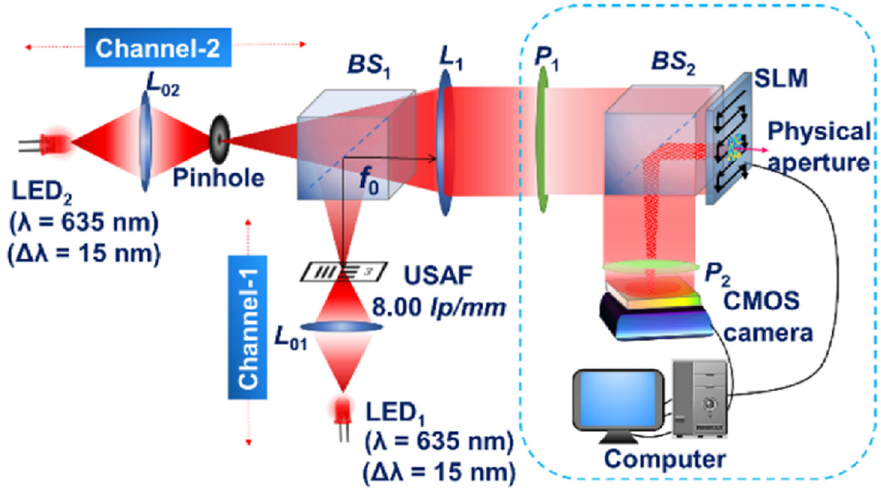
Figure 12. COACH optical setup using a synthetic aperture for super-resolution imaging. Reprinted with permission from [66]. Copyright (2021) Optical Society of America.